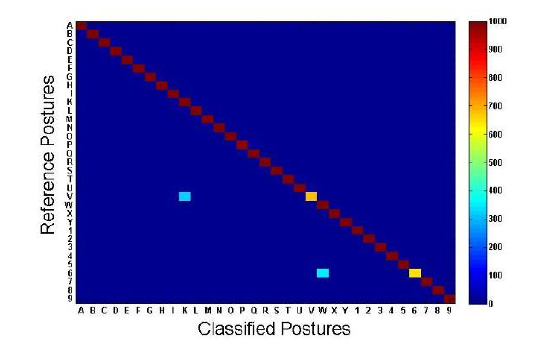
Figure 8. Confusion Matrix of the 33000